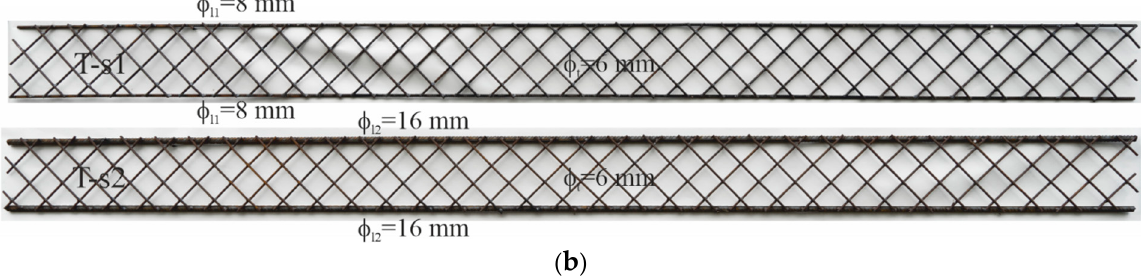
Figure 3. Plane meshes for the truss reinforcement of beams Series 1 T-s1 and Series 2 T-s2 : ( a ) general view, ( b ) transverse view.